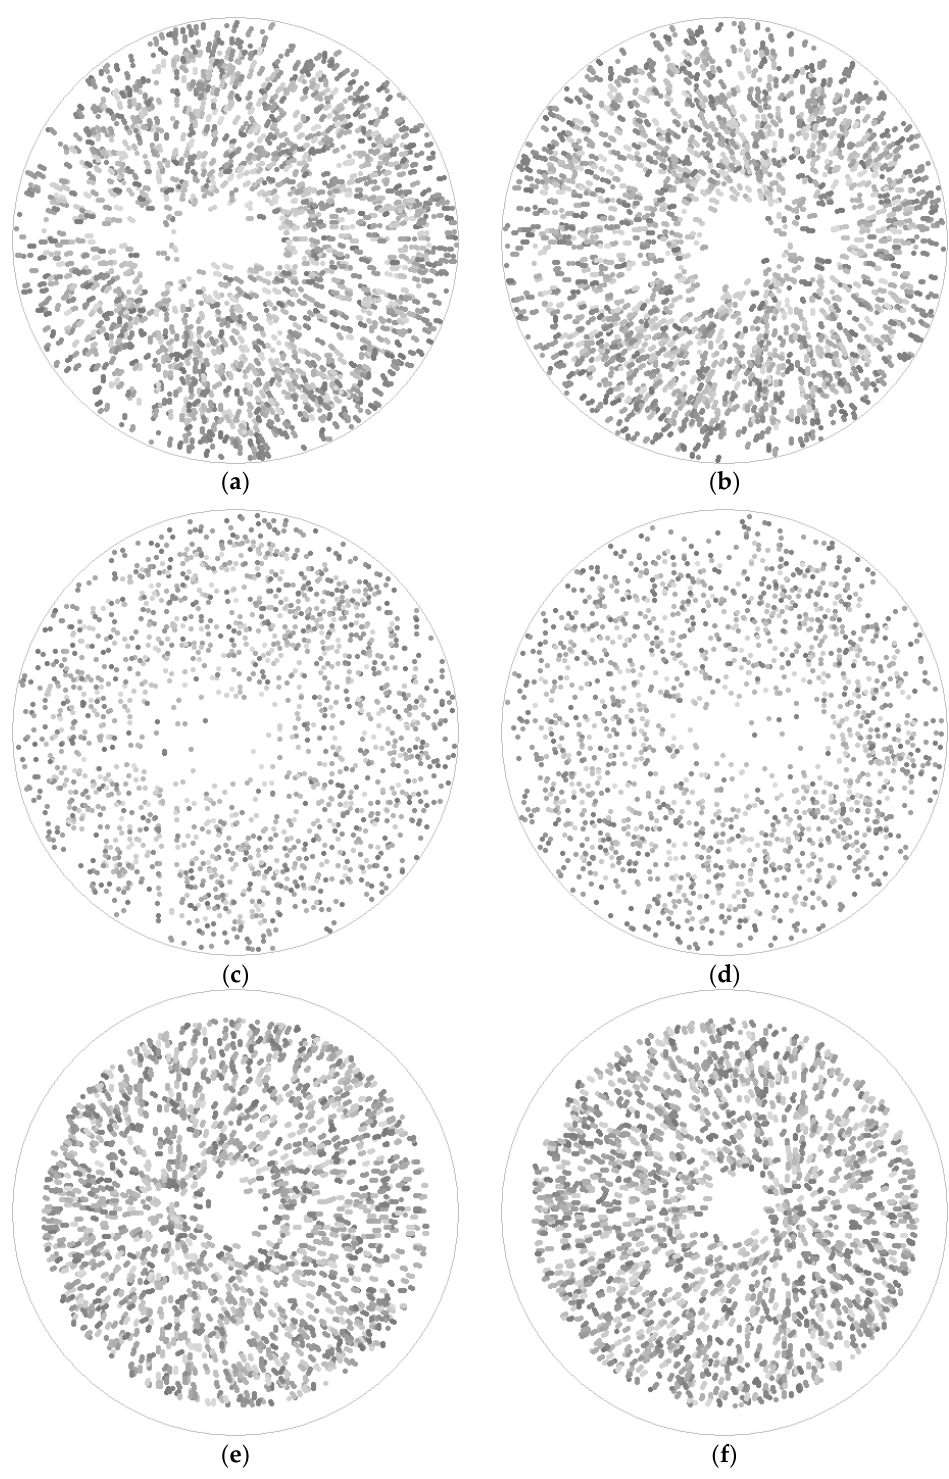
Figure 9. Stimuli ( a ) cl1409 (combined, left), ( b ) cr1409 (combined, right), ( c ) fl1409 (flicker, left), ( d ) fr1409 (flicker, right), ( e ) ml1409 (motion, left), ( f ) mr1409 (motion, right).